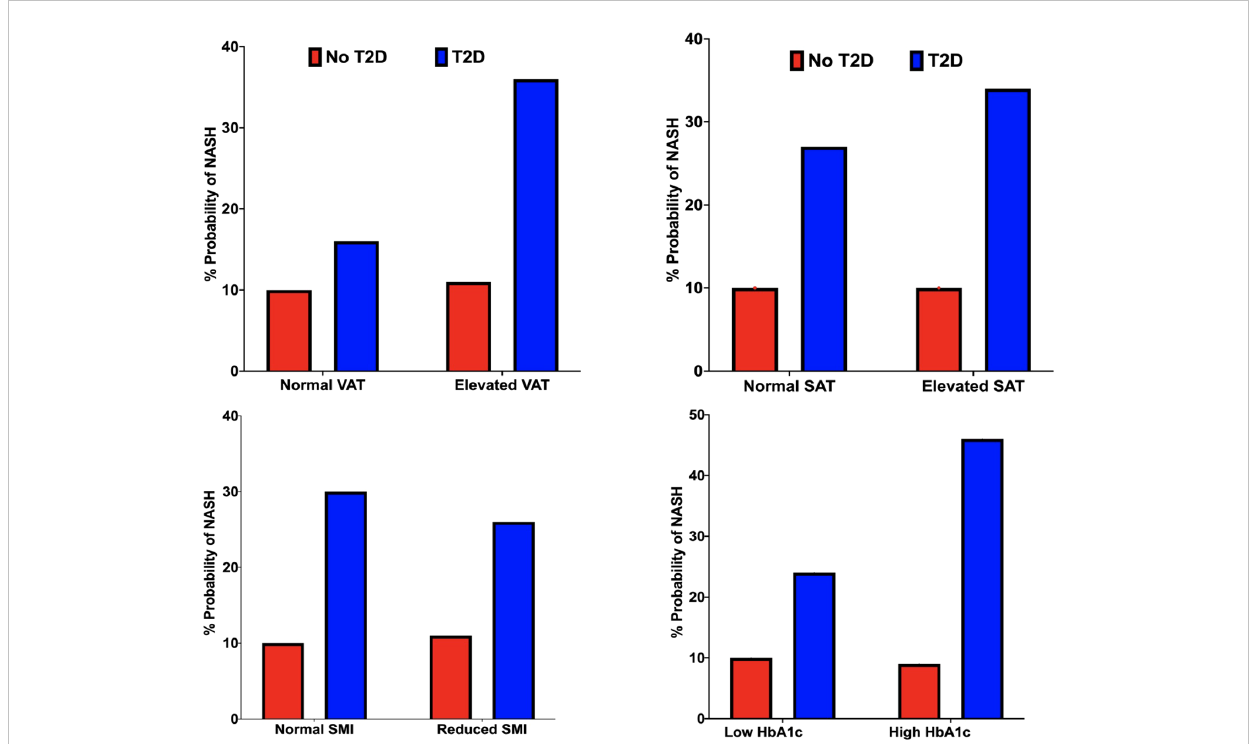
FIGURE 5 Probability of NASH (%) under VAT (top left), SAT (top right), SMI (bottom left) and HbA1c status (bottom right) conditions in the non-T2D (red) and T2D (blue)